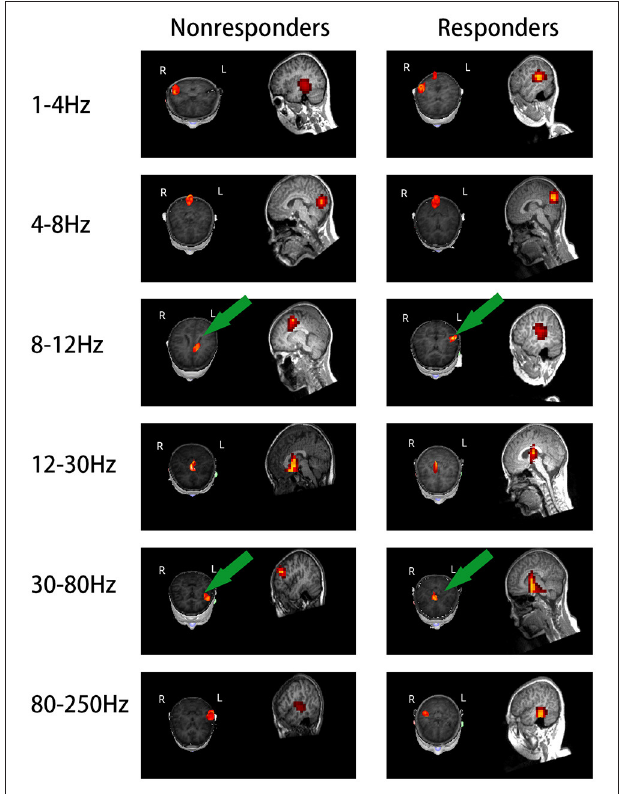
FIGURE 2 | Images of magnetic localization at 1–250Hz frequency band. Significant differences were labeled with a green arrow. The location in the nonresponders was mainly in the frontal cortex area at 8–12 and 30–80Hz, especially at 8–12Hz, as opposite to the responders; the nonresponders showed activation in the medial frontal cortex